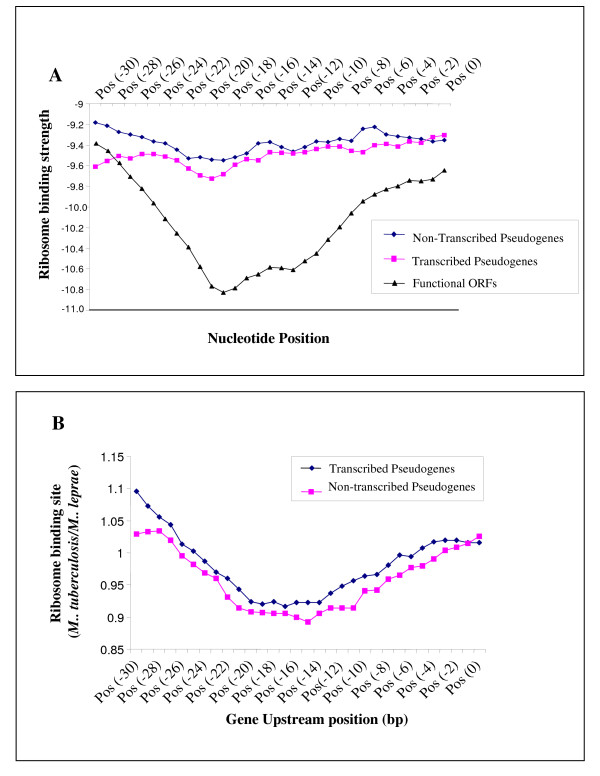
Ribosome binding strength of M leprae genes. Graphs show the relative ribosomal binding strength of M. leprae genes. Panel A shows free energy values of the binding between the 3' sequence of the 16S rRNA and the region upstream of pseudogenes and ORFs. The position of the start codon of the genes is denoted by Pos (0). Lower values indicate stronger binding strength. Panel B shows the RBS ratios of M. leprae pseudogenes and their corresponding M. tuberculosis homologs.